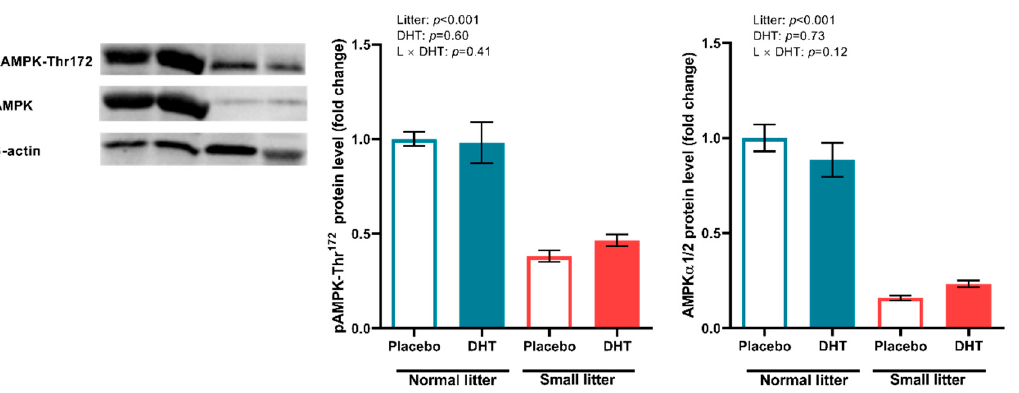
Figure 6. The protein levels of phosphorylated and total AMPK, and their relative ratio in the VAT of placebo and DHT treated rats from small and normal litters. All protein levels were measured in cytosolic fraction of VAT, normalized to β actin. Representative Western blots are shown. The data are presented as mean ± SEM ( n = 6 animals per group). To determine the effects of litter size reduction and DHT treatment, as well as their interaction, two-way ANOVA, was performed, and the difference was considered significant at p < 0.05.